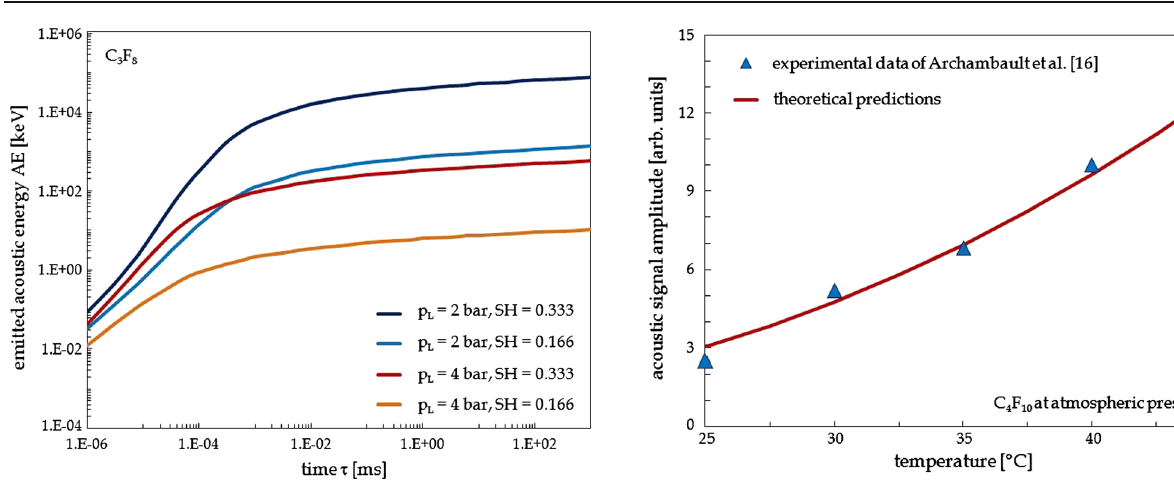
Fig. 8 Predicted vs. measured acoustic signal amplitudes for C 4 F 10 at p